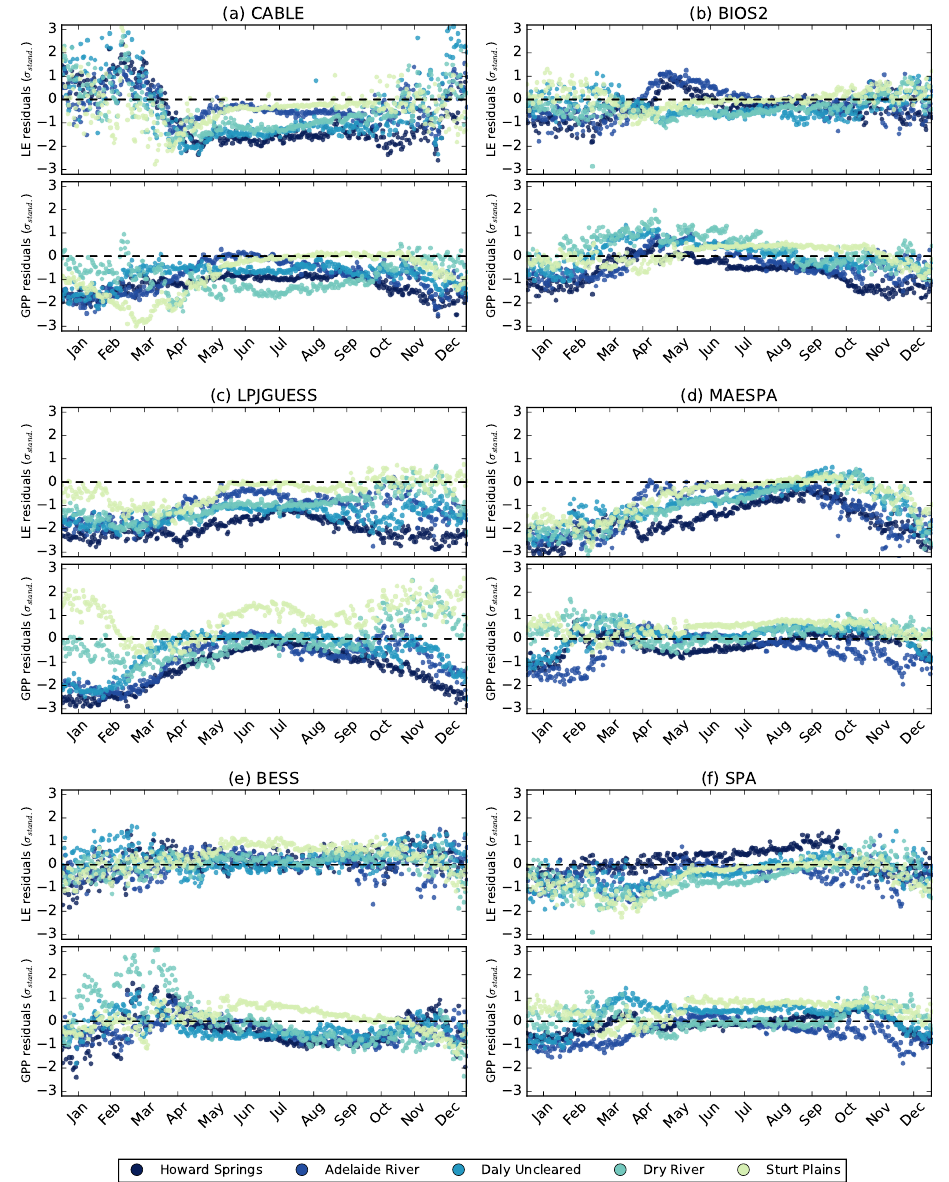
Figure 4. Standardised model residuals for latent energy (LE) and gross primary productivity (GPP) expressed in units of standard deviations (SD) [(modelled flux – observed flux)/SD(observed flux)]. Residuals are presented for each model: (a) CABLE, (b) BIOS2, (c) LPJGUESS, (d) MAESPA, (d) BESS, and (e) SPA, where each flux site is represented by a blue–green–yellow gradient. For both fluxes, the residuals are plotted against time (ensemble average year) and against the flux prediction